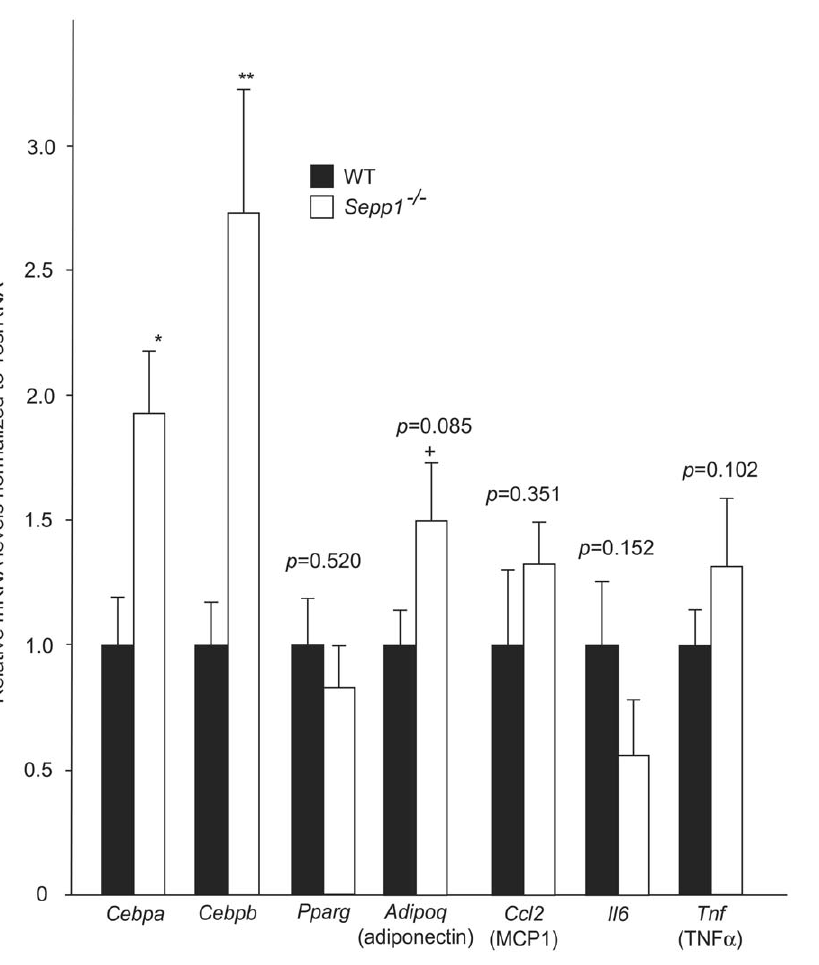
Figure 4. Expression of genes involved in adipogenesis and inflammation in the adipose tissue of selenoprotein P-knockout and wild-type mice fed a high fat, high sucrose diet (n=5–10). RNA was isolated from epididymal fat of mice. Data represents the means 6 SEM. + p , 0.1, *p , 0.05, **p , 0.01, vs. wild-type mice.